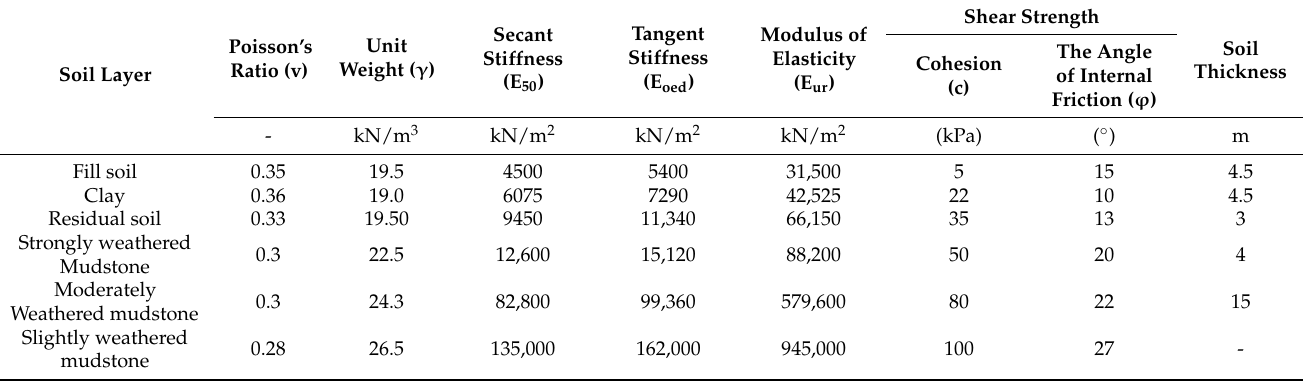
Table 1. The soil layer parameters.